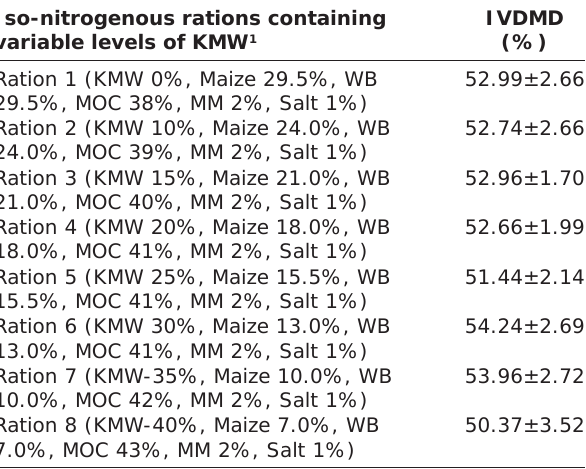
Table-1: In vitro dry matter digestibility of composite ration comprising of variable levels of KMW.